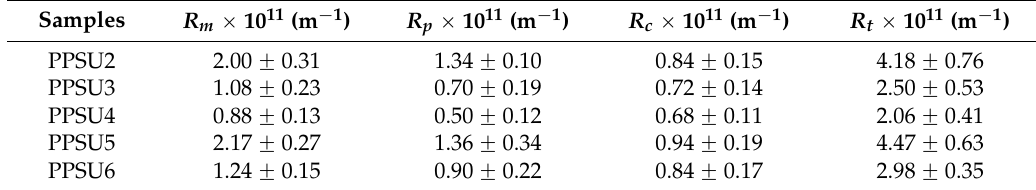
Table 4. Analysis of filtration resistances of PPSU UF